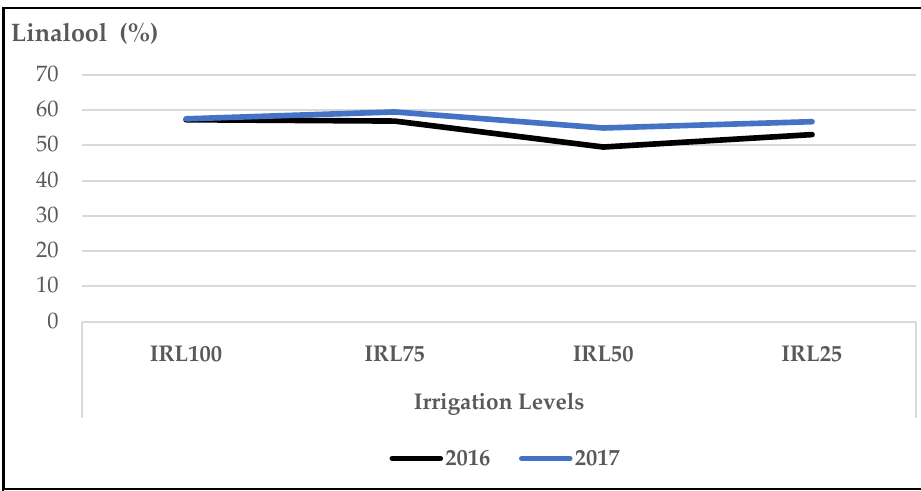
Figure 1. Mean values of linalool (%) at different IRLs of O. basilicum L. essential oil; IRL 100 = 100% FC; IRL 75 = 75% FC; IRL 50 = 50% FC; IRL 25 = 25% FC without SM.